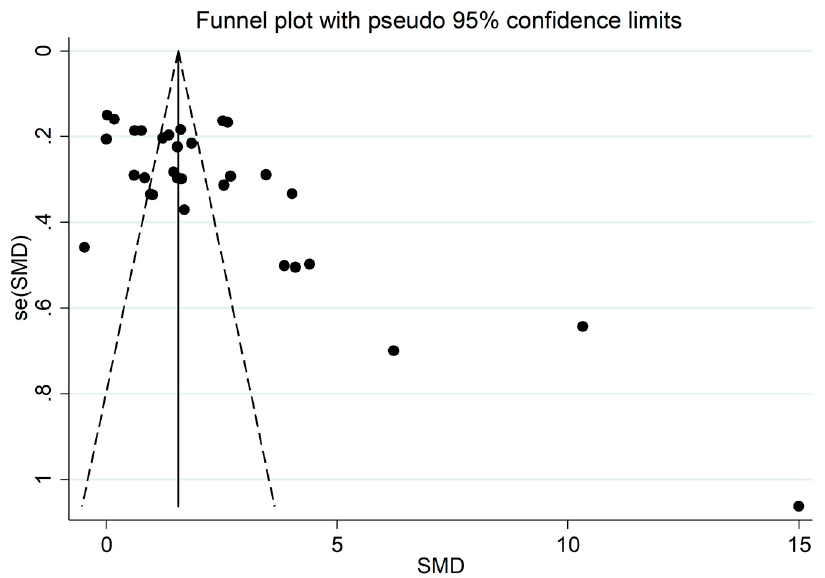
Figure 4. Funnel plot of studies investigating ischaemia-modified albumin concentrations in pa- tients with acute coronary syndrome and controls.